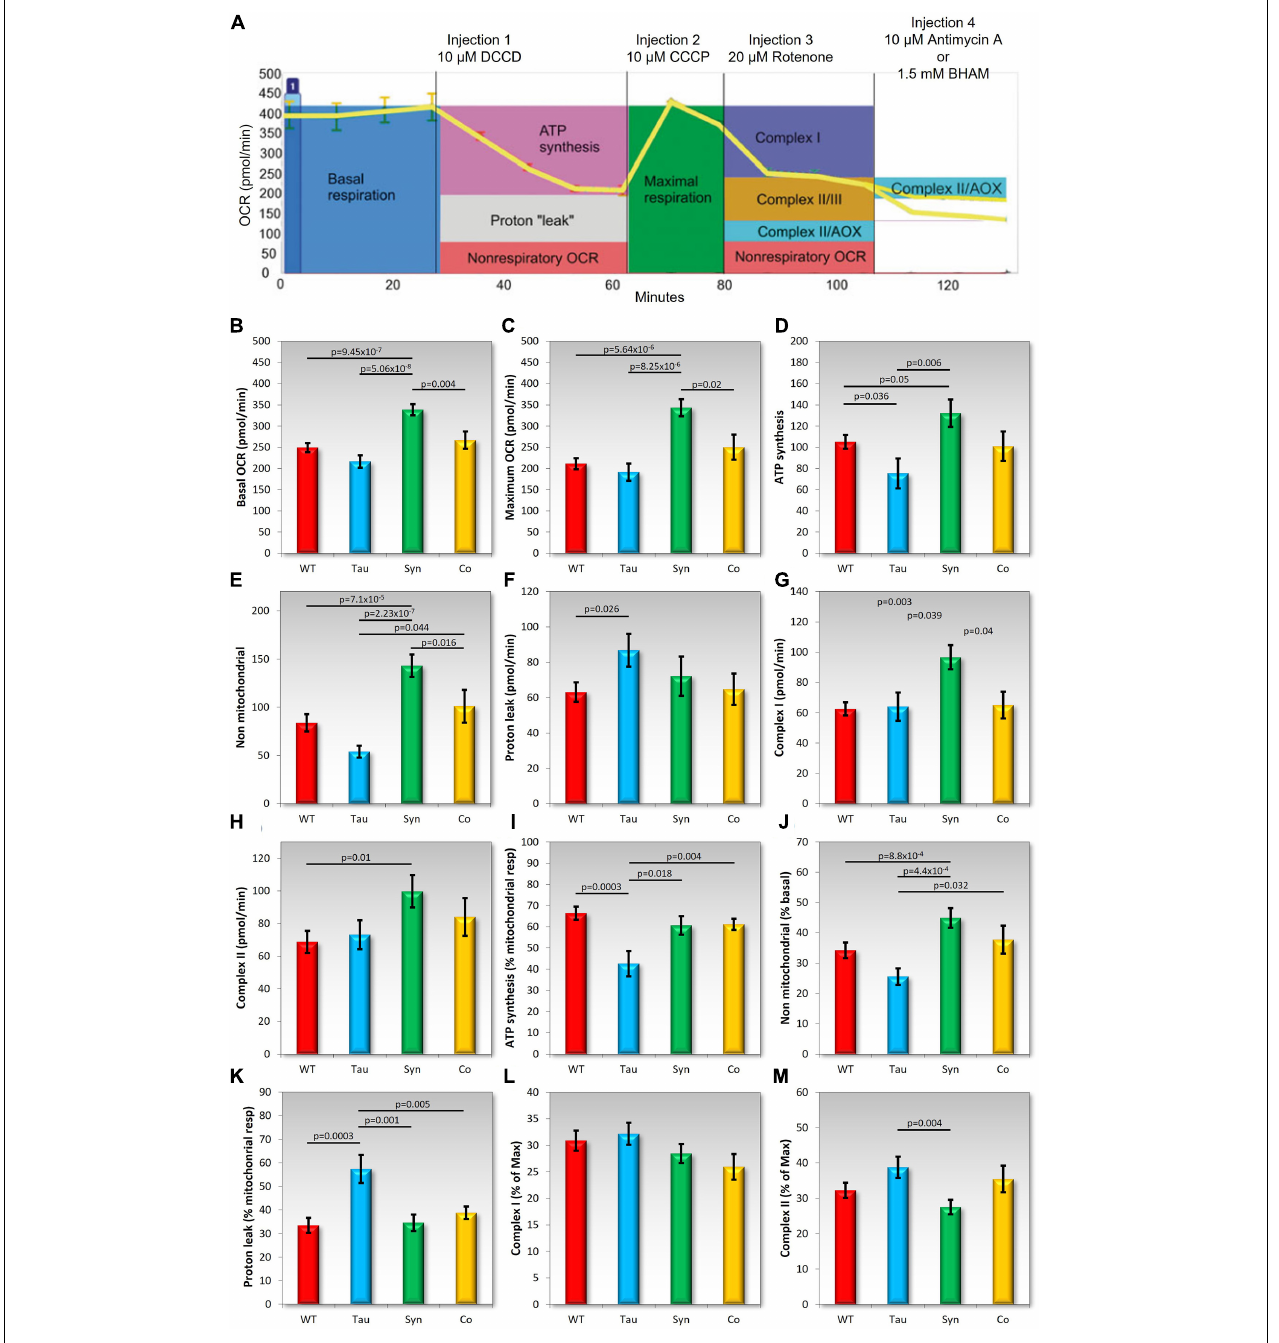
FIGURE 7 | Tau impairs mitochondrial ATP synthesis and coexpression with α -synuclein rescues the defect. In each experiment, cells of the D. discoideum parental strain (AX2), and strains expressing tau or α -synuclein alone or in combination were plated in four wells per sample of a Seahorse XFe24 plate. Mitochondrial respiration was measured as the oxygen consumption rate (OCR) using the Seahorse XFe24 Analyzer following the addition of pharmacological agents. The following agents were added sequentially [as seen in panel (A) and into all wells: DCCD (dicyclohexylcarbodimide), CCCP (carbonyl cyanide m-chlorophenyl hydrazone), and rotenone]. Then either Antimycin A or BHAM (benzohydroxamic acid) was added to the wells. The coloured boxes in panel (A) indicate how each component of the respiratory chain was measured (Lay et al., 2016). Total activity for Complex II was calculated by adding the effects of Antimycin A and BHAM. Panels (B–H) represent each component of mitochondrial respiration measured by the OCR. Each strain was assayed as four replicates per experiment across an average of 3–6 experiments. Horizontal bars with p values represent statistically significant pairwise comparisons using the t- test. All other pairwise differences were not statistically significant. Error bars are a standard error of the mean. The following components were measured: (B) Basal OCR, (C) , maximum OCR, (D) ATP synthesis, (E) non-mitochondrial respiration, (F) proton leak, (G) Complex I activity, and (H) Complex II activity. As seen previously, D. discoideum